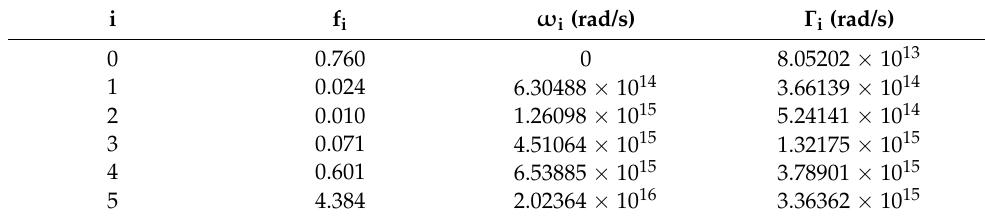
Table 2. Values of the Drude–Lorentz model.